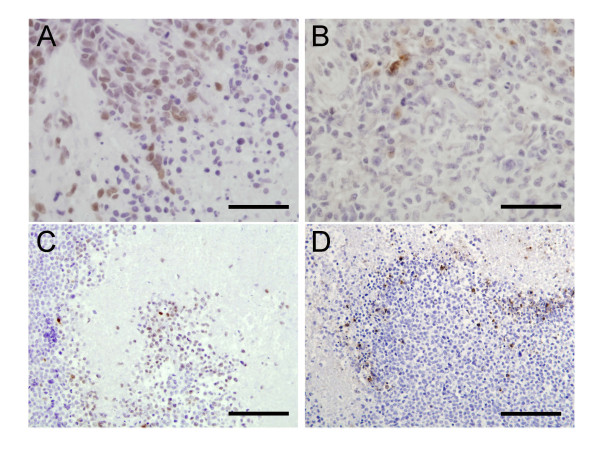
Expression of HIF in Ewing's sarcoma. (a) HIF-1α and (b) HIF-2α expression in Ewing's tumour cells; scale bar = 50 μm. Expression of HIF-1α (c) co-localises with that for cleaved caspase 3 (d); scale bar = 100 μm.